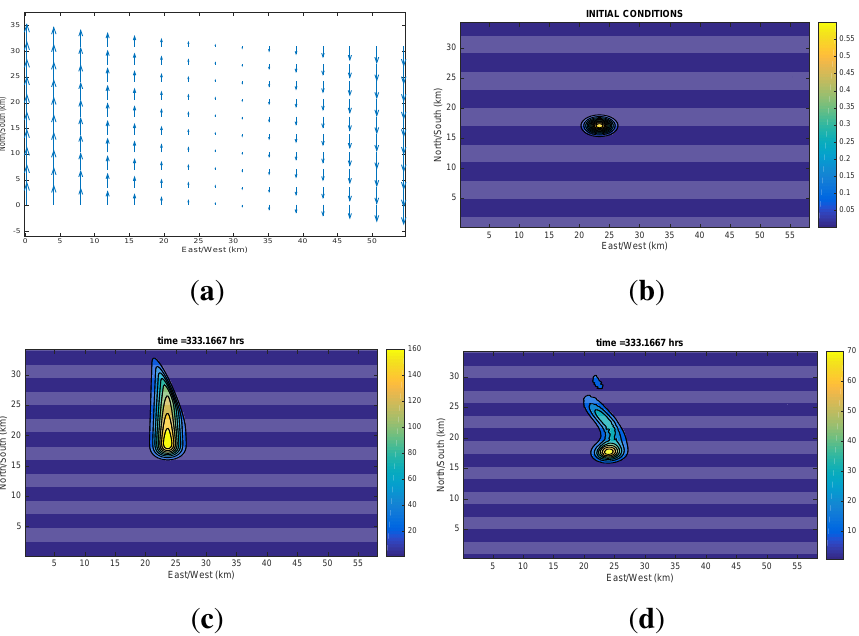
Figure 13. Waves can localize a spill: ( a ) the steady currents; ( b ) The source location. ( c ) Spill under the action of the shear flow; ( d ) spill under the action of shear and Stokes drift advection.